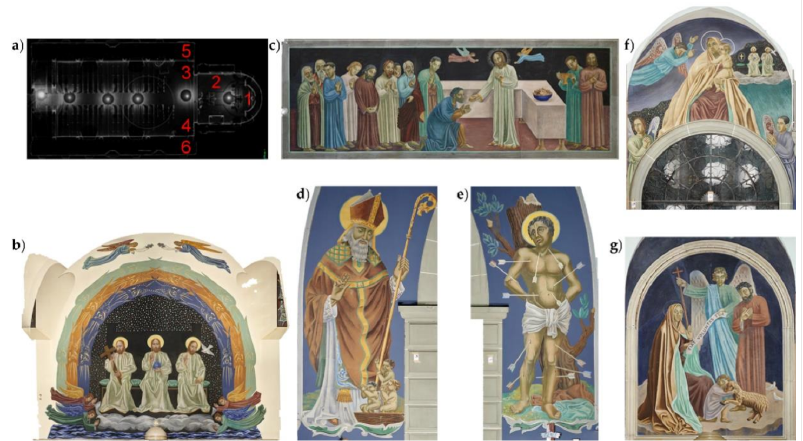
Figure 2. ( a ) Church plan with indication of the wall paintings’ locations: 1. Trinity (6.7 m × 5.6 m) ( b ); 2. Eucharist (6 m × 2.2 m) ( c ); 3. Saint Nicolas (1.7 m × 4 m) ( d ) 4. Saint Sebastian (1.7 m × 4 m) ( e ); 5. Virgin and Child (2.5 m × 1.8 m) ( f ); 6. Holy family (2 m × 2.6 m) ( g ). Orthophotos by Arch é otech SA